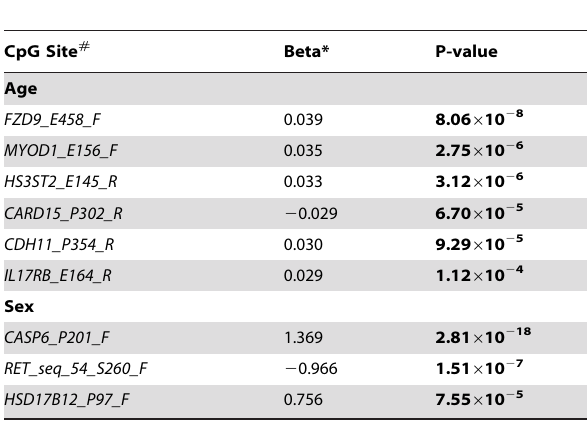
Table 2. Significant age and sex associations with DNA